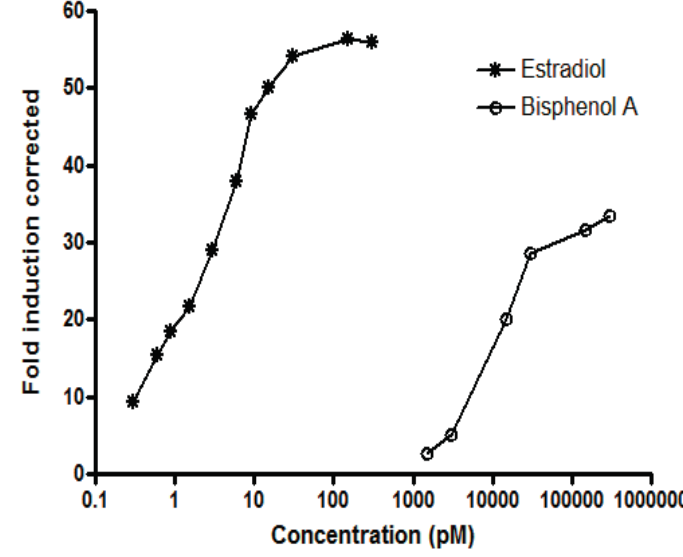
Figure 1. Dose-response curves of increasing concentrations of estradiol and bisphenol A.